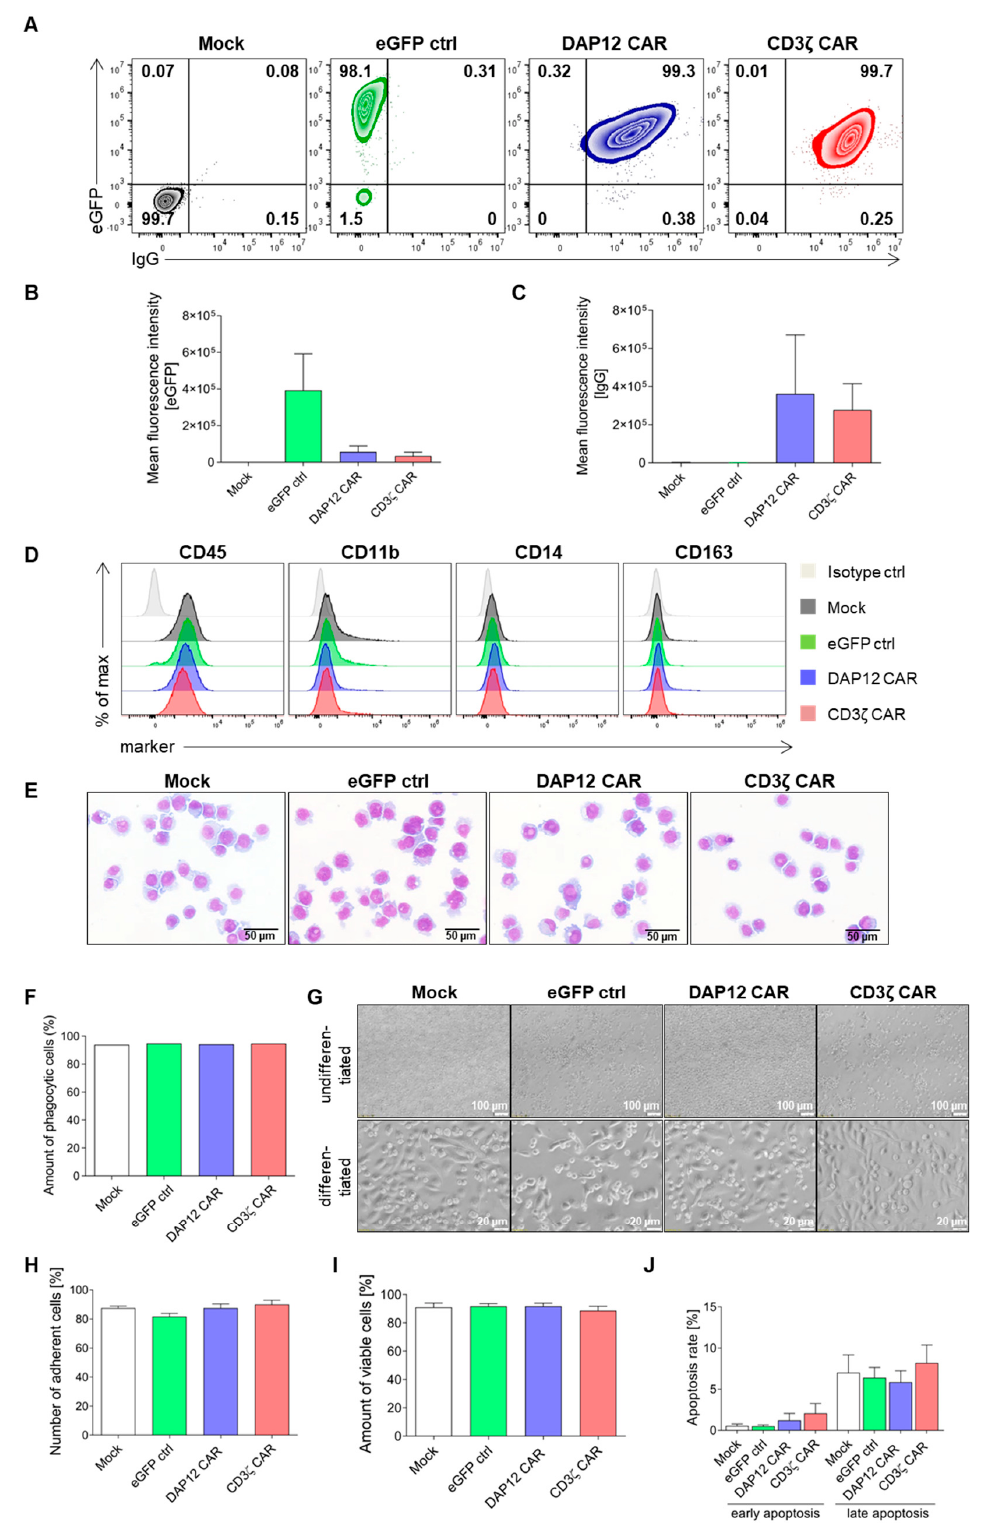
Figure A2. Characterization of THP-1 cells transduced with CAR constructs. ( A ) Representative flow cytometric analyses of eGFP and CAR expression in THP-1 cells. Mean fluorescence intensity of ( B ) eGFP and ( C ) IgG expression in THP-1 cells. Data are represented as the mean ± s.e.m. of n = 3 biological replicates. ( D ) Flow cytometric analyses of monocytic surface markers on unmodified (mock) and modified THP-1 cells ( n = 2). ( E ) Microscopic analyses of THP-1 cell morphology using